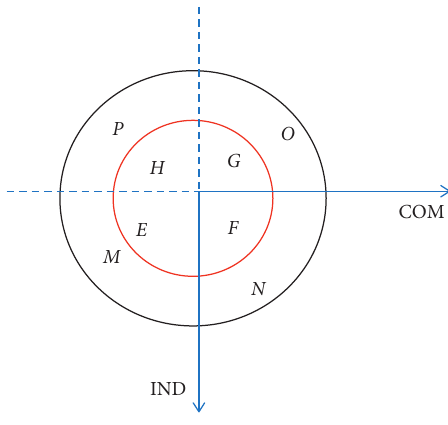
Figure 5: The lower part of the